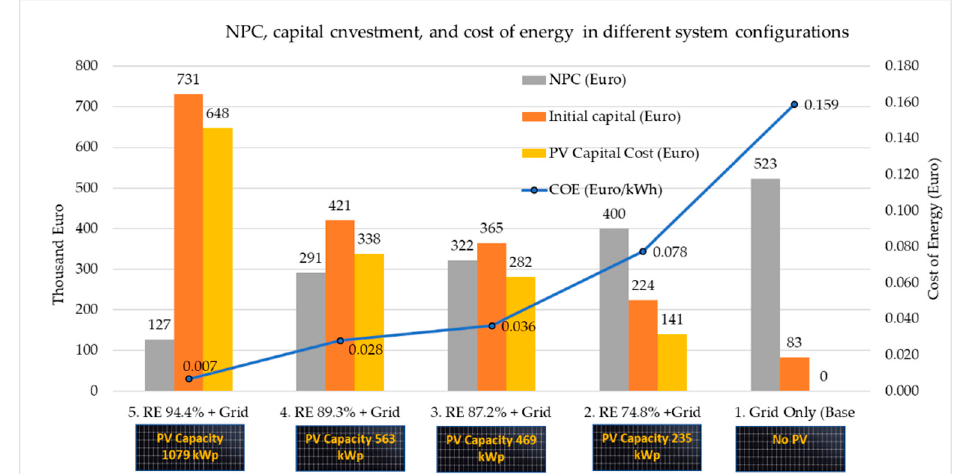
Figure 14. Net present cost (NPC), capital investment and cost of energy (COE) in different system configuration. Right axis shows the cost of energy while the left axis shows NPC (grey bars), capital investment for the whole system (orange bar) and PV capital cost (yellow bar).